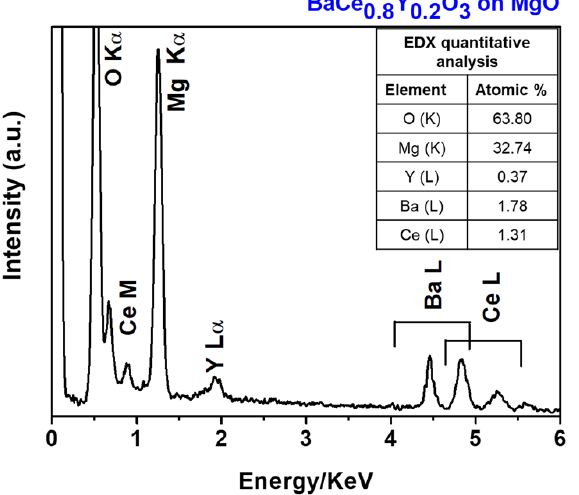
Figure 8. EDX spectrum of the BaCe 0.8 Y 0.2 O 3 film grown on the MgO substrate at a deposition temperature of 950 °C.